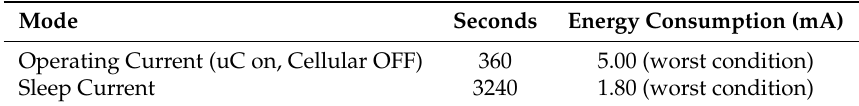
Table 8. Particle electron energy consumption in recovery mode.